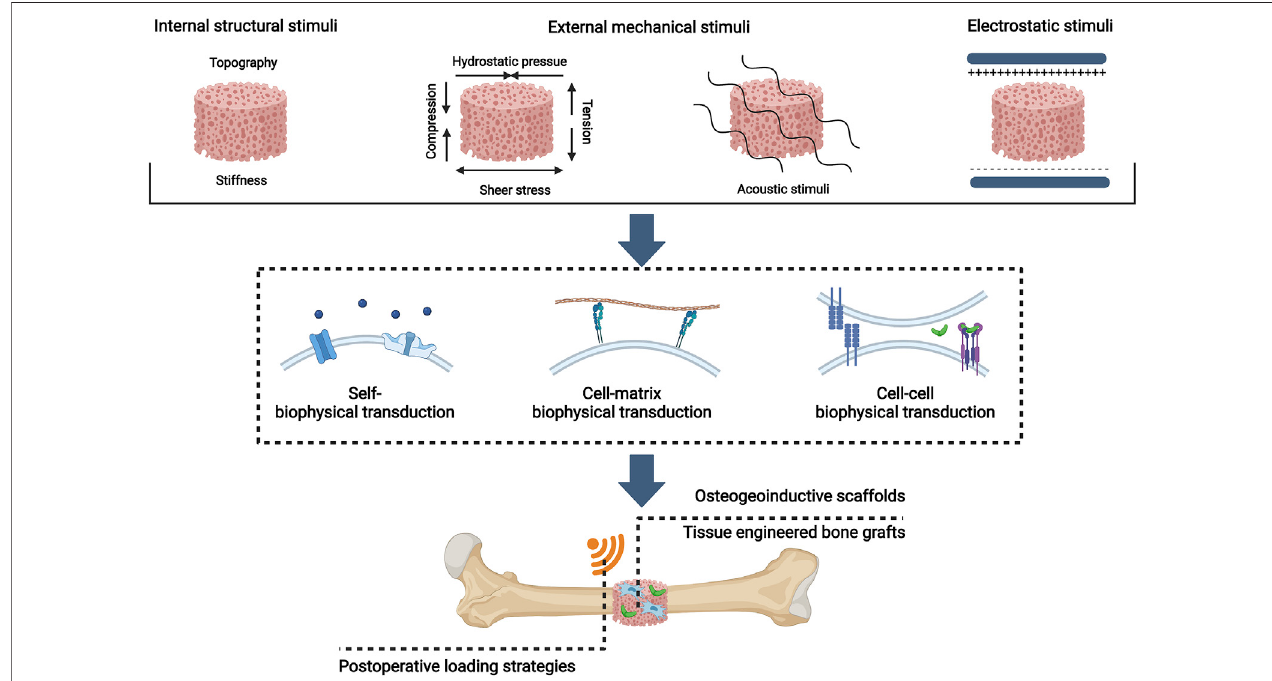
FIGURE1| Overviewofbiophysicalstimuliforbonetissueengineering:distinctivepatterns,osteoinductivemechanisms,andbonetissueengineeringapplications. Created with BioRender.com.